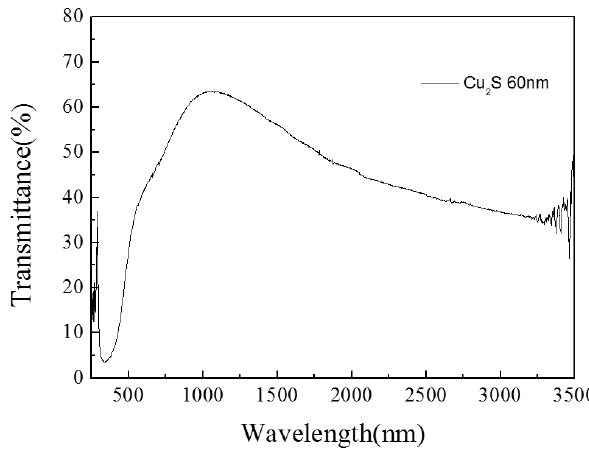
Figure 5. The transmittance diagram of Cu 2 S/glass complex films for different thickness.